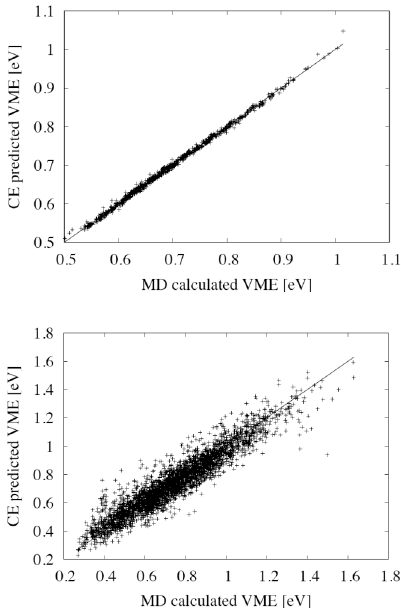
Fig. 6. Cluster expansion VME predictions for the FeCu1nn (up) and FeVac1nn problems (down), with only pair interactions taken into consideration. The average errors are respectively 0.53% and 7.12%.